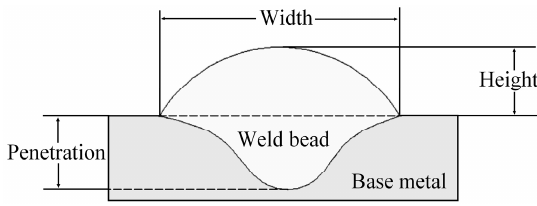
Figure 1. Weld bead geometric characteristics (cross-section).